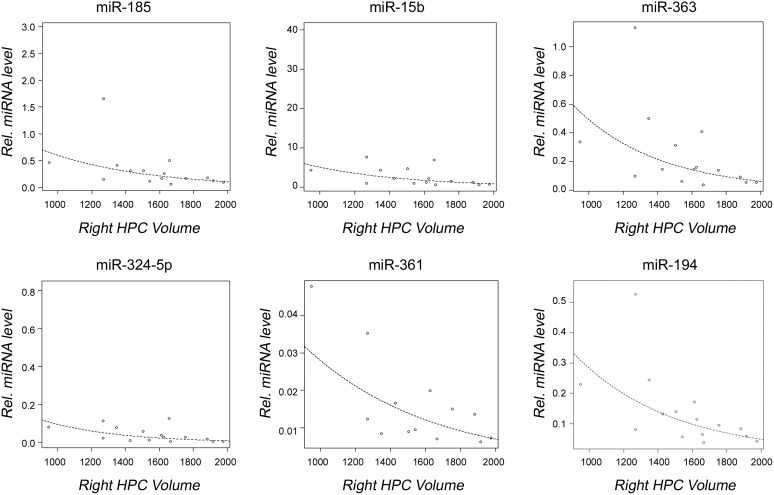
Observed correlation between dysregulated miRNAs and right hippocampal volume.Graphs showing a significant correlation between miRNA expression levels and right hippocampal volume within the individuals with 22q11DS are shown. Open circles represent individuals with 22q11DS; the line represents line of best fit. P-values given are for each miRNA.